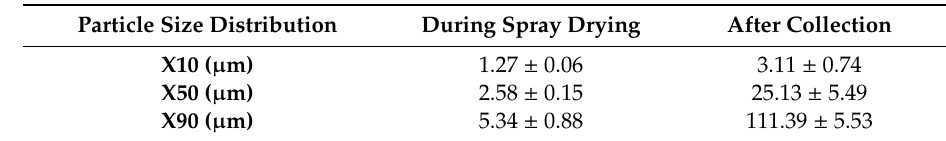
Table 3. Laser di ff raction data of spray-dried pure isoniazid during spray drying and after collection ( N = 2).